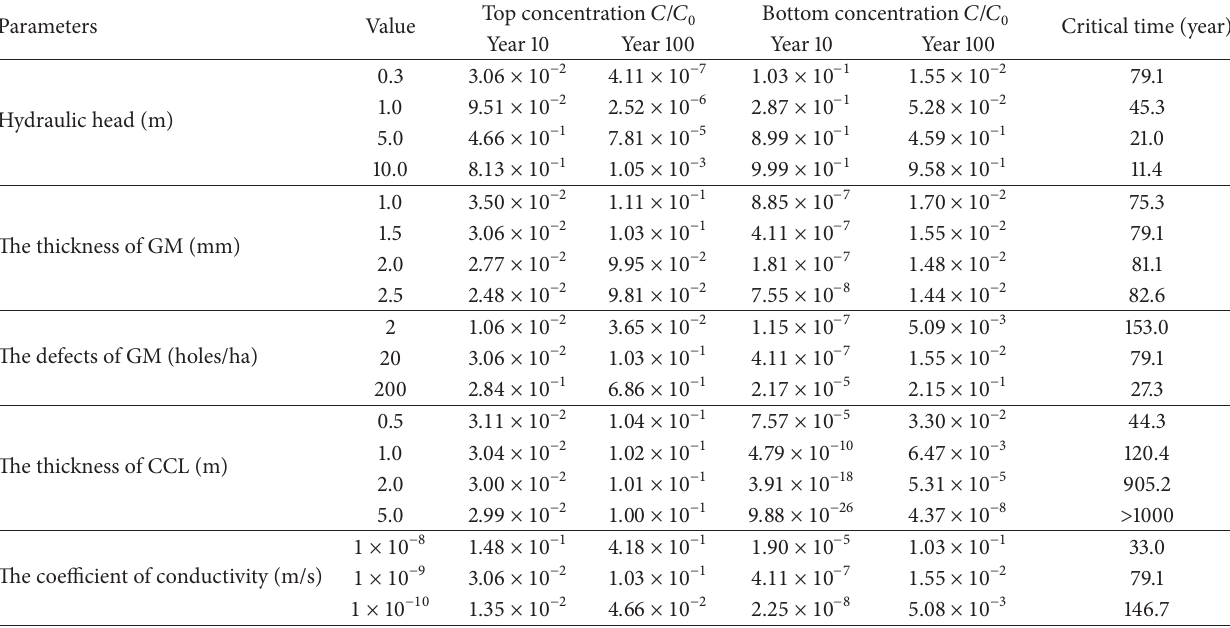
Table 6: Leakage characteristics of the liner